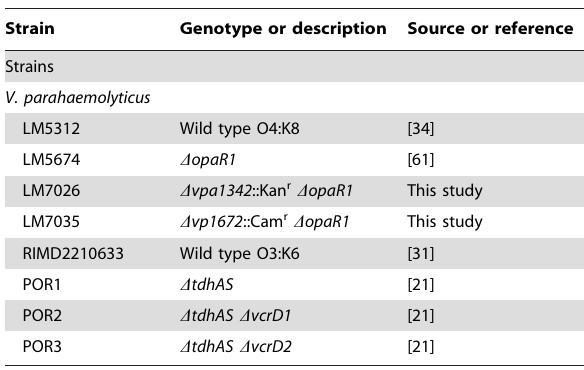
Table 1. Bacterial